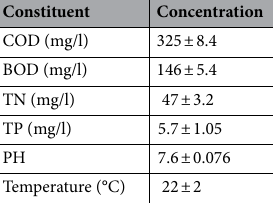
Table 1. The characteristics of the wastewater used in this